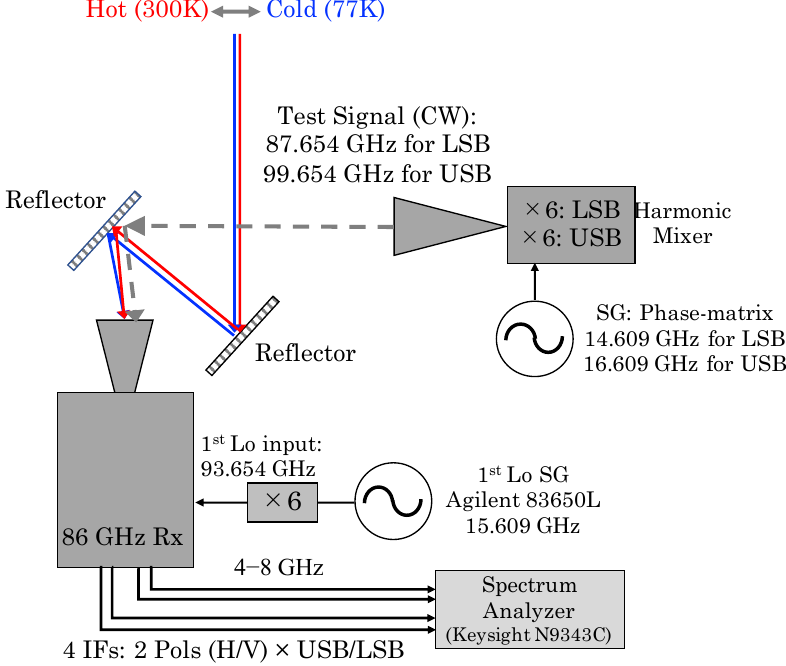
Figure 4. Schematic diagram for measurement of the Image Rejection